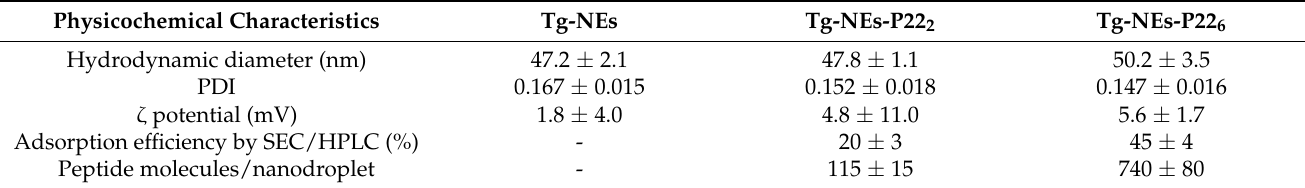
Table 5. Physicochemical characteristics of nanoemulsions ( n ≥